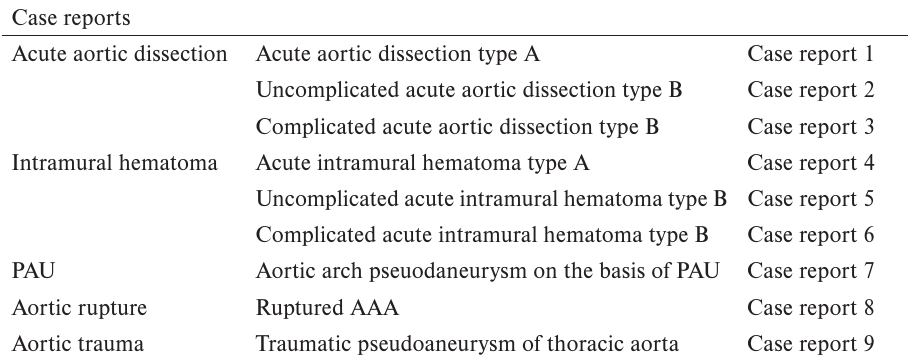
Table 4. Case reports in